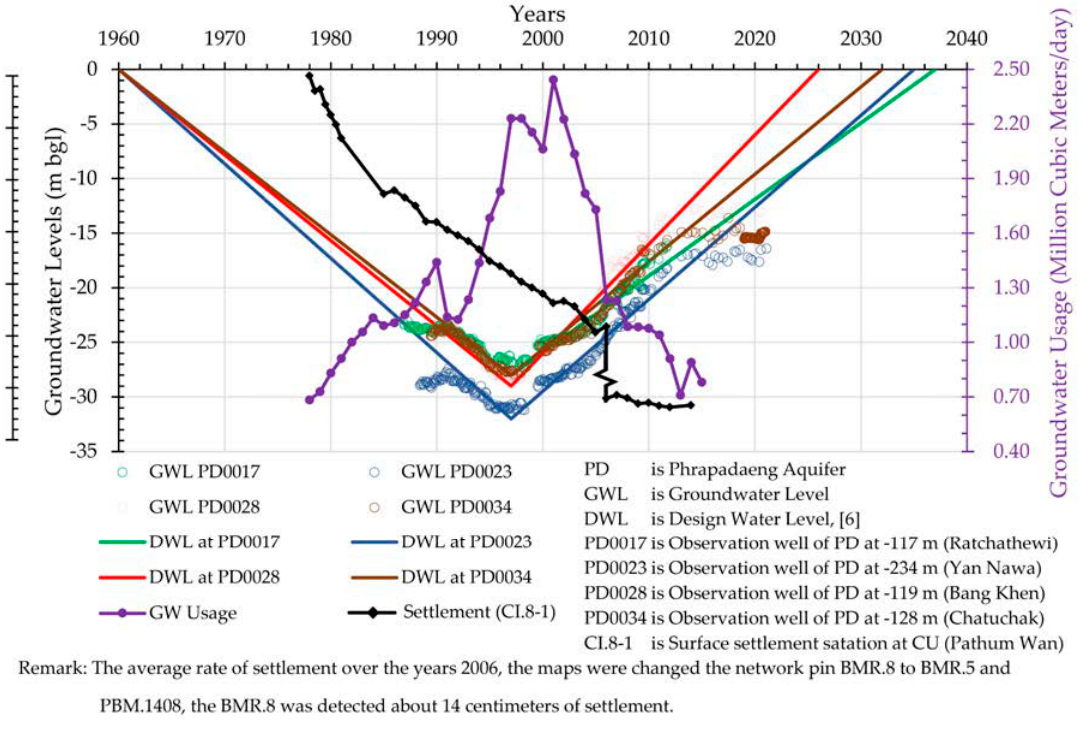
Figure 2. Groundwater levels changed with time in Bangkok.